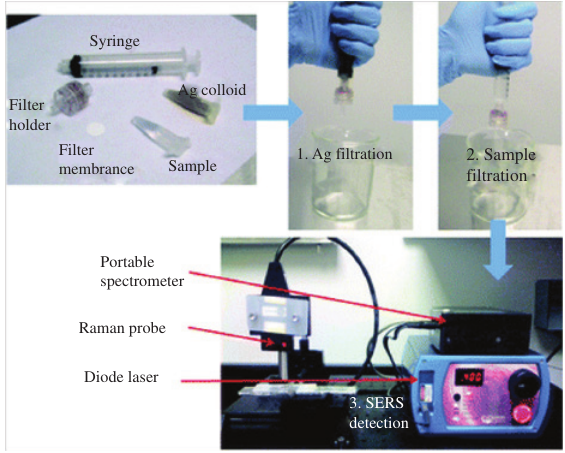
Figure 11: SERS-active substrates are created simply by passing a silver colloid solution through a filter membrane using a syringe. Analyte molecules are concentrated into the substrate from a large sample volume. The SERS signal is detected using a small and porta- ble photonic setup. Reprinted with permission from [193]. Copyright 2012 American Chemical